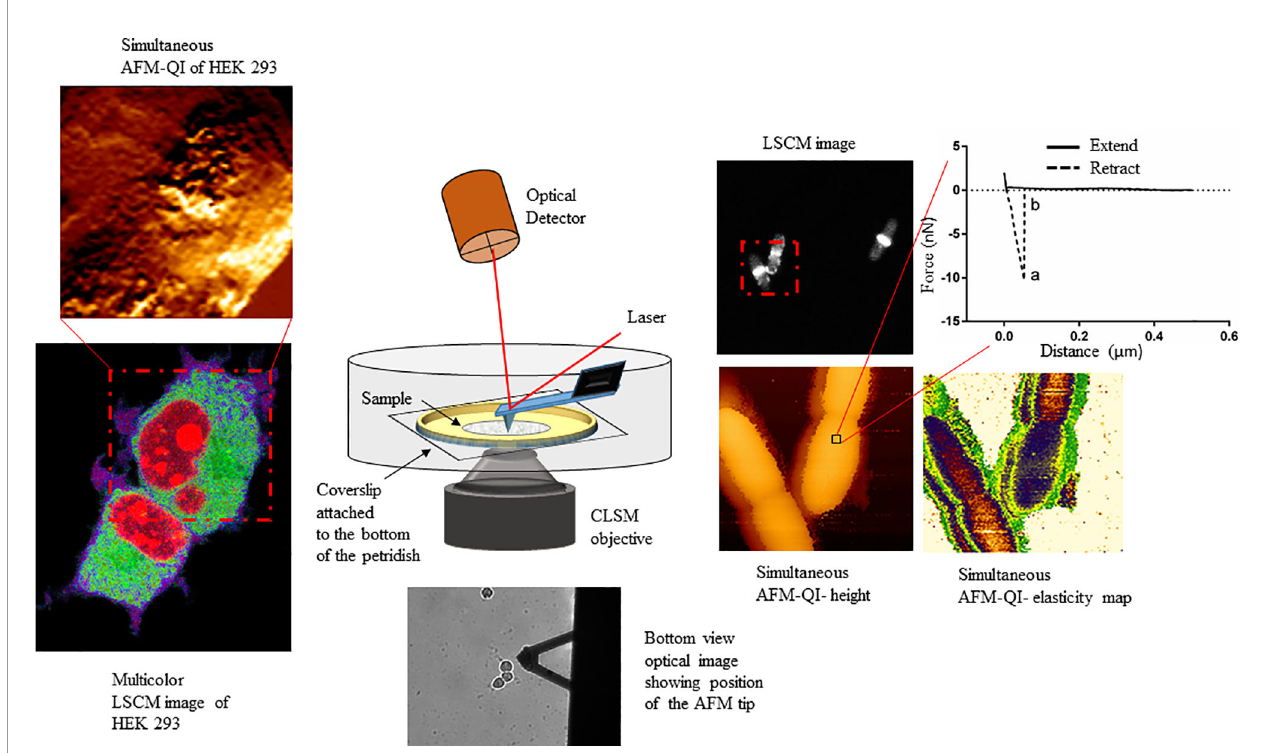
FIGURE 1 | Schematic showing the multiplexed data arising from correlative atomic force-confocal microscopy. AFM in quantitative imaging (QI ™ ) mode quanti fi es elasticity, adhesion (extracted from nanoscopy curves, top right) and surface topography, while confocal can localize multiple fl uorescently labeled molecules within the sample (bottom left). Simultaneous imaging can be conducted in live, physiologically relevant conditions in real-time. This method can be easily extrapolated to characterizing human-pathogen interactions, in the presence or absence of therapeutics, at the single-cell level. This fi gure has been reproduced from Bhat et al. (2018b) with permission from Scienti fi c Reports